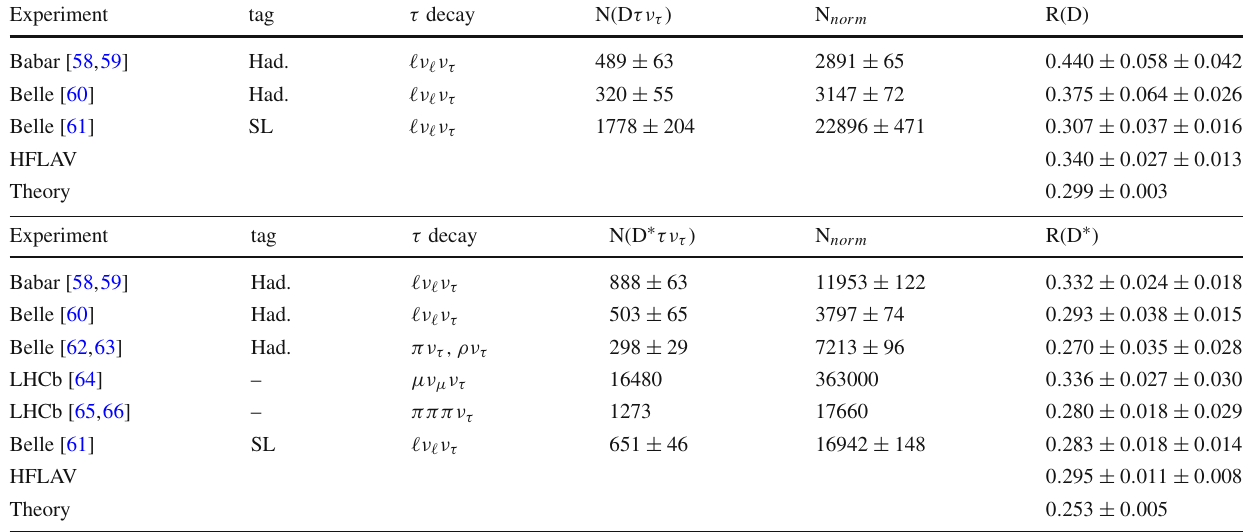
Table 2 Summary of R D and R D ∗ measurements and theoretical pre- dictions. The number of observed signal and normalization events is also reported. The normalization channel is B → D ( ∗ ) (cid:4)ν (cid:4) for all mea- surements but the LHCb one with three-prong τ decays, where the nor- malizationchannelisB → D ∗ πππ .ThelatterLHCbmeasurementhas